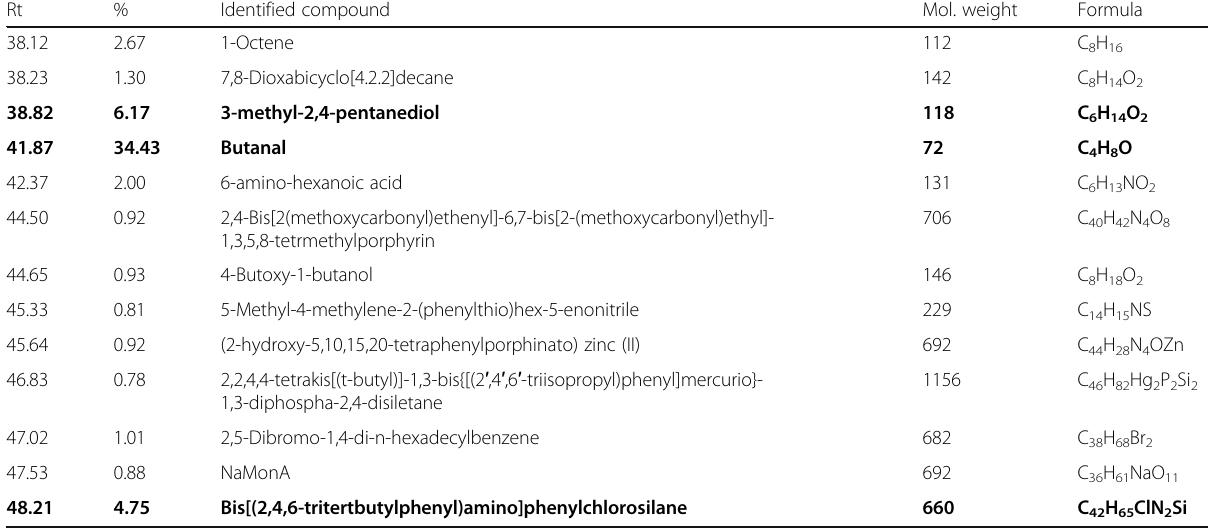
Table 4 GC/MS analysis of the M. oleifera leaves extract after incorporating Ag-NPs (Continued)